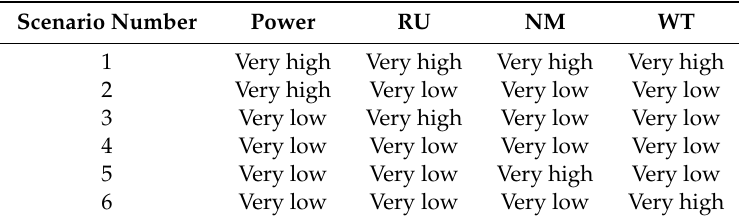
Table 10. Scenario for energy e ffi ciency.